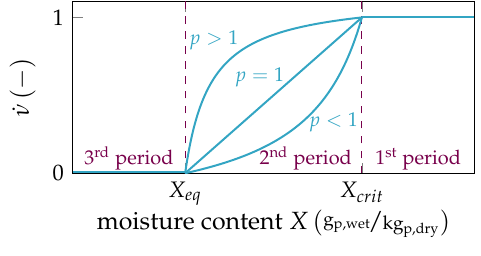
Figure 4. Normalized drying velocity ˙ ν over moisture content of particles X as introduced by van Meel [24] dependent on different p